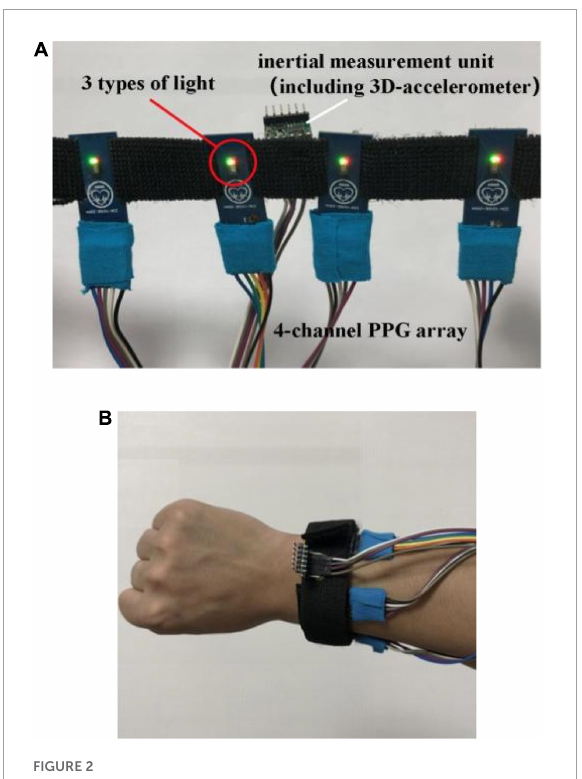
FIGURE2 Schematic diagram of (A) the acquisition device and (B) the wearing